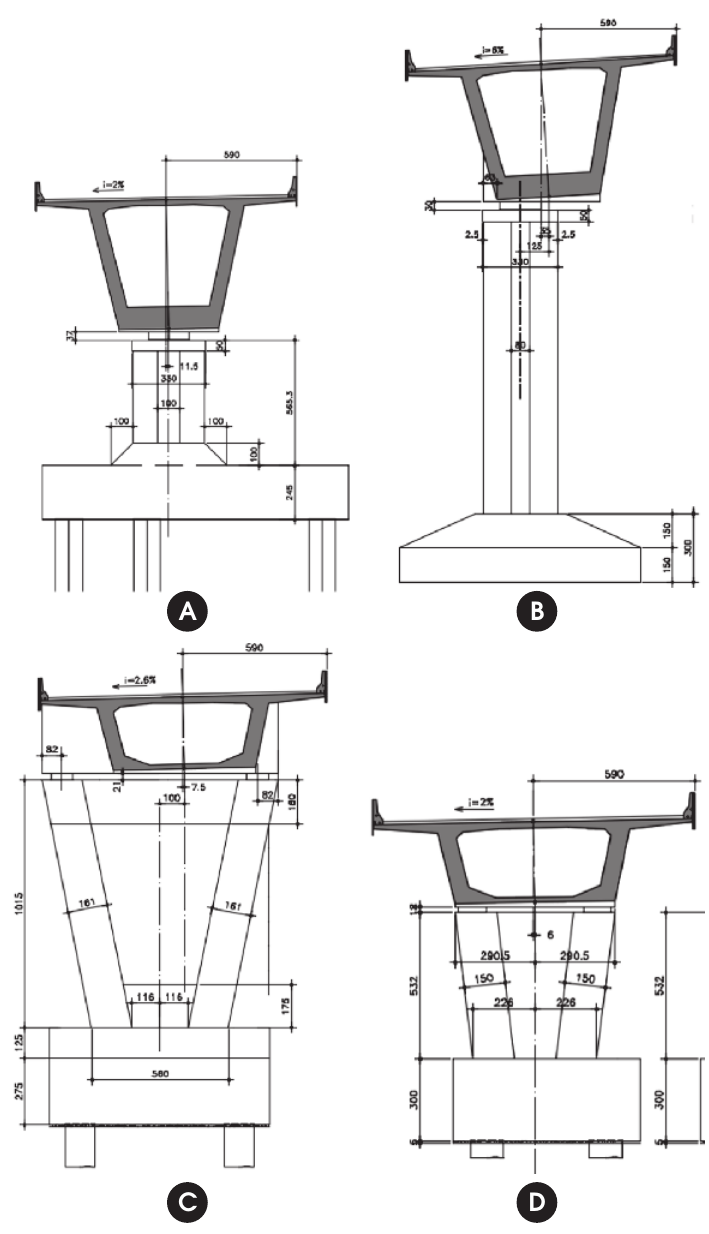
Cross-sections on pillars: (a) P1 (b) P2 e P3 (c) P4 (d) P5 (drawing supplied by EGT Engenharia)